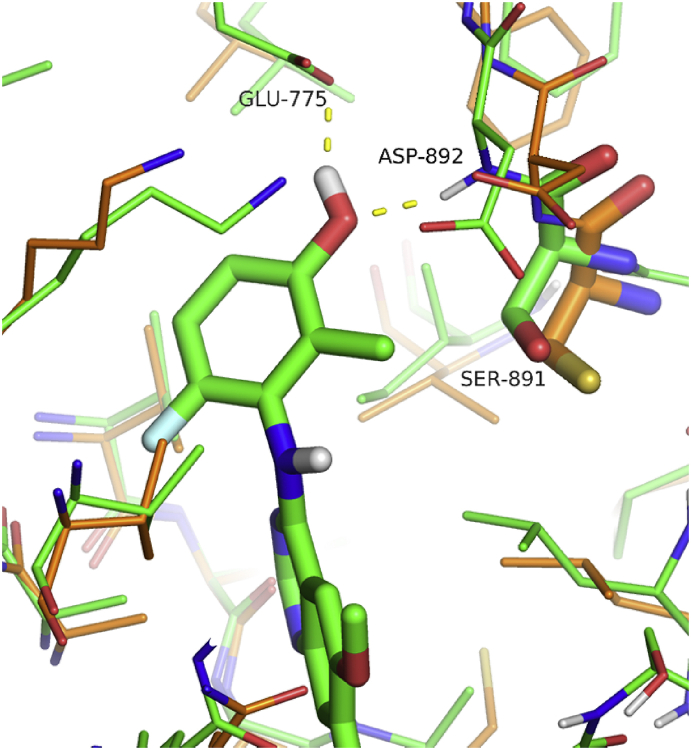
Compound 36 modelled in RET (green carbon atoms), compared with the aligned X-ray structure of KDR (PDB 3CJG, orange carbons). The R1 methyl group approaches close to the sidechain of Ser891 of RET, equivalent to the bulkier Cys1045 of KDR. (For interpretation of the references to colour in this figure legend, the reader is referred to the web version of this article.)